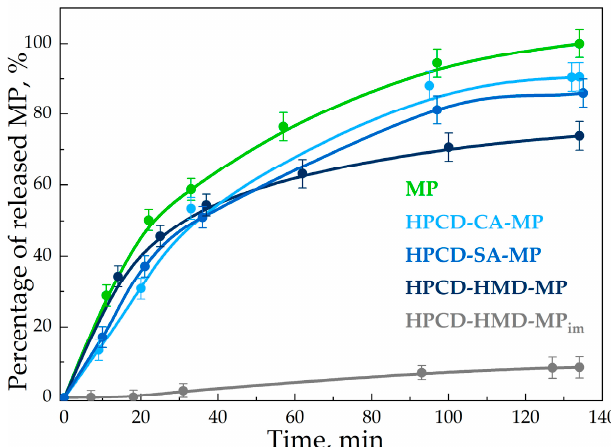
Figure 9. The release kinetics of MP, HPCD-CA-MP, HPCD-SA-MP, HPCD-HMD-MP, and HPCD- HMD-MP im , C MP = 0.3 mM, 37 °C. HMD-MP ◦ im , C MP = 0.3 mM, 37